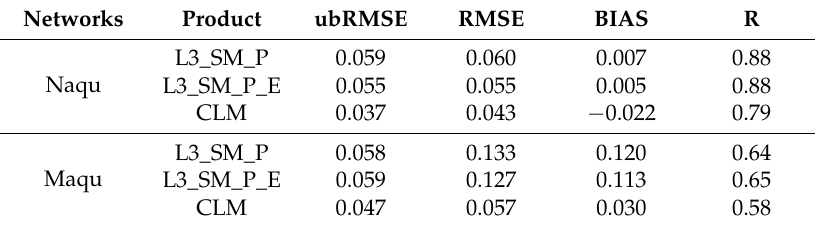
Figure 2. Comparison of the Soil Moisture Active Passive (SMAP) L3 soil moisture product against in situ soil moisture data for the Naqu and Maqu network: ( a ) the time series for the Naqu network; ( b ) the scatterplot for the Naqu network; ( c ) the time series for the Maqu network; and ( d ) the scatterplot for the Maqu network. Blue triangles represent the standard SMAP soil moisture product, green circles represent the enhanced SMAP soil moisture product, orange squares represent the CLM simulations, and black solid lines represent the in-situ observations. Table 1. Performance of the Soil Moisture Active Passive (SMAP) L3_SM_P and L3_SM_P_E products as well as Community Land Model (CLM) simulations for the Naqu and Maqu network, respectively 1